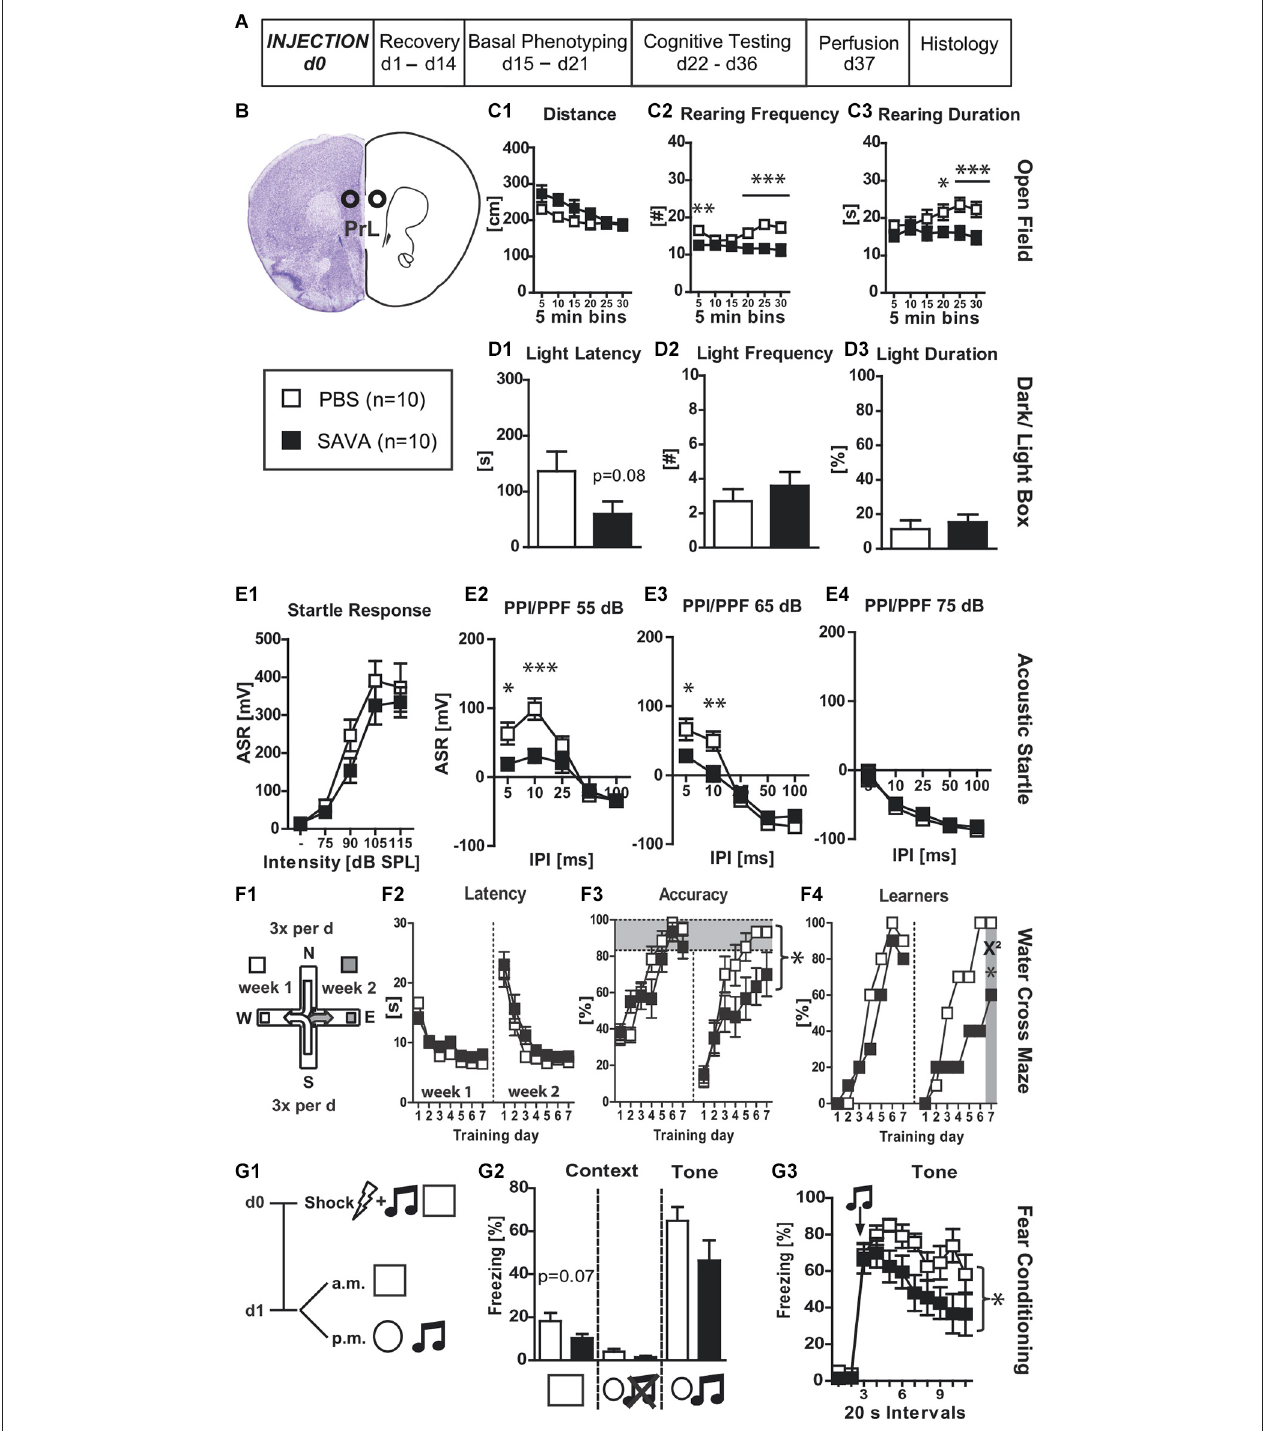
each side (l 0.5; a-p +1.9; v 2.5 mm from Bregma); groups and sample size for Experiment I ; (C1–3) OF behavior; (D1–3) D-L behavior (E1–4) ASR as basic Input/Output curve and PPI/PPF curves after a 55, 65, 75 dB pre-pulse, respectively, for 5 different IPIs; (F1) basic schema of WCM; (F2–4) learning parameters for WCM; (G1) timeline for FC: tone-shock pairing on d0; testing ( Continued